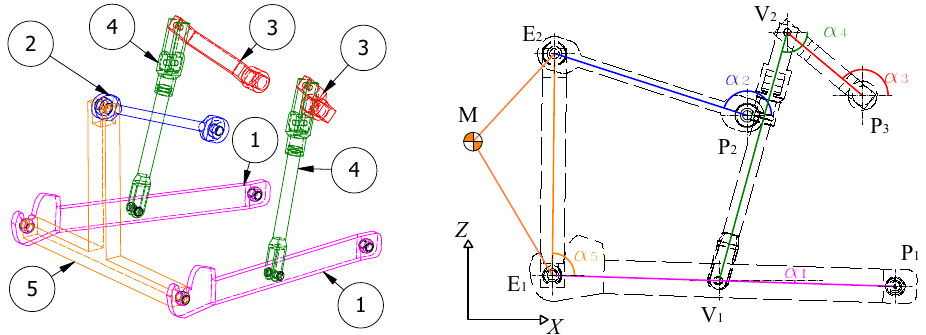
Figure 2. Three points linkage. ( Left ) 3D scheme. ( Right ) kinematic scheme.